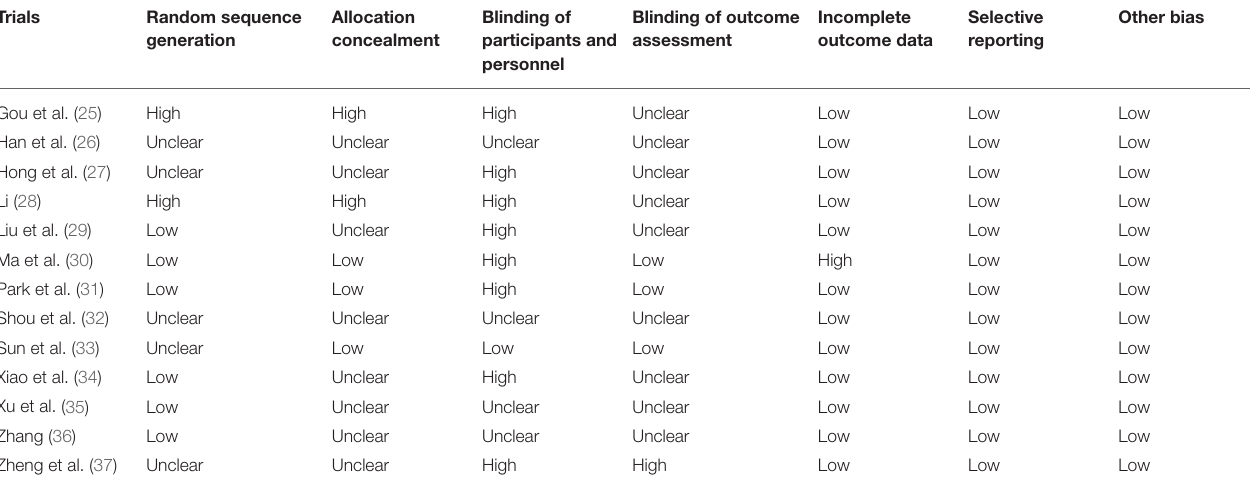
TABLE 1 | Risk of bias